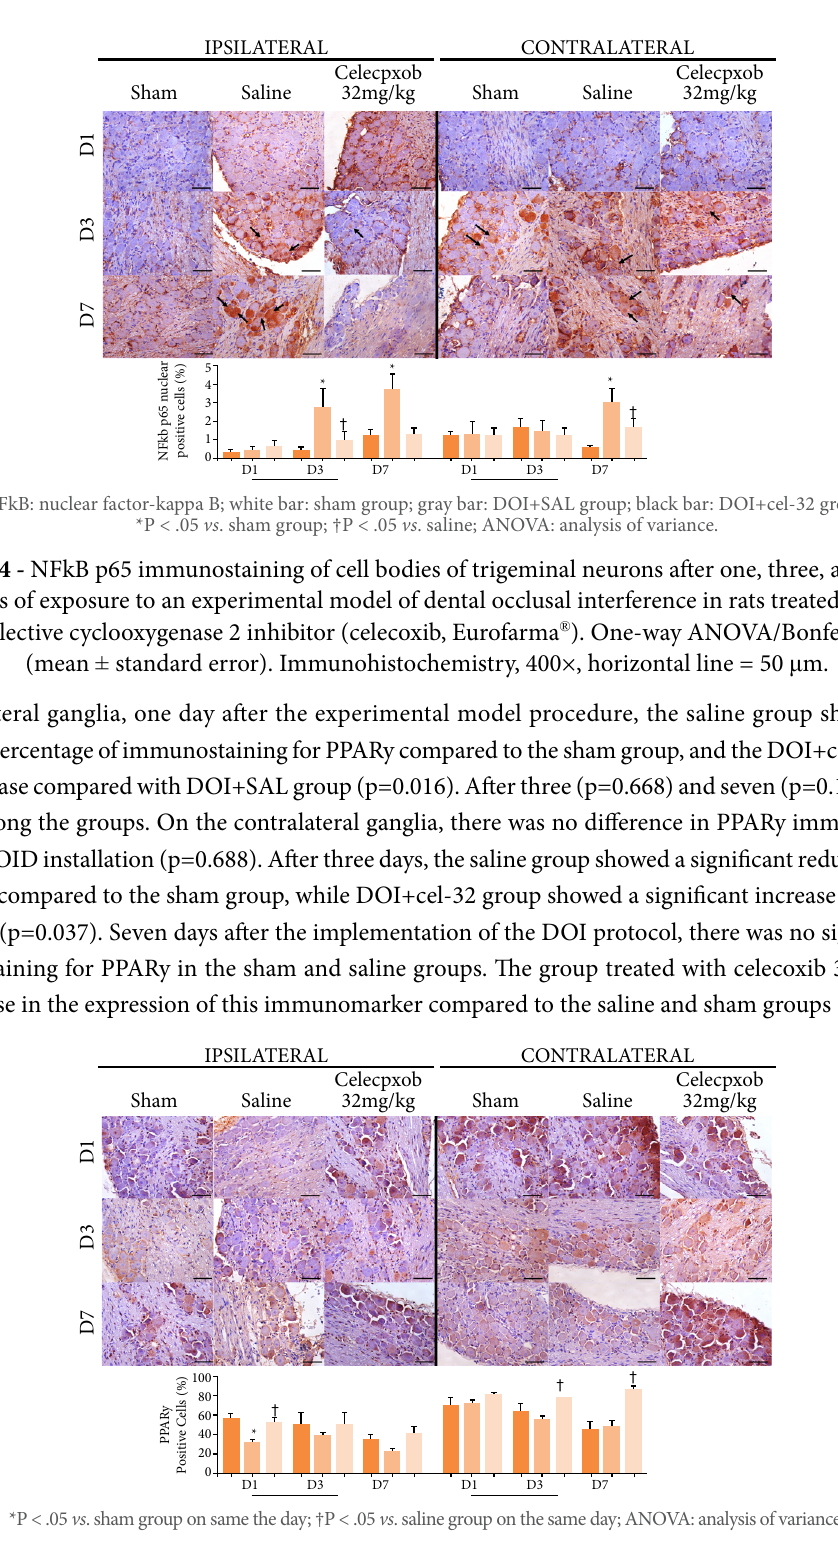
Figure 5 - Peroxisome proliferator-activated receptor-y immunostaining of cell bodies of trigeminal neurons after one, three, and seven days of exposure to an experimental model of dental occlusal interference in rats treated with a selective cyclo-oxygenase-2 inhibitor (celecoxib, Eurofarma ® ). One-way analysis